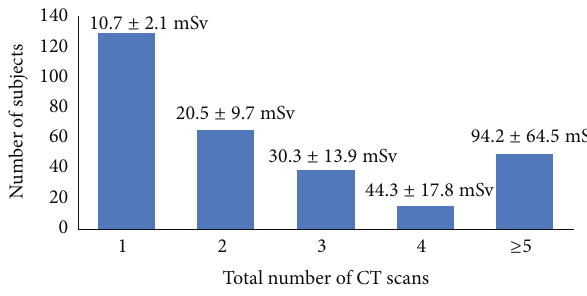
Figure 1: Number of CT scans received by subjects over four years inclusive of the initial pulmonary CTA for suspected PE. Mean effective radiation dose is displayed over each subject